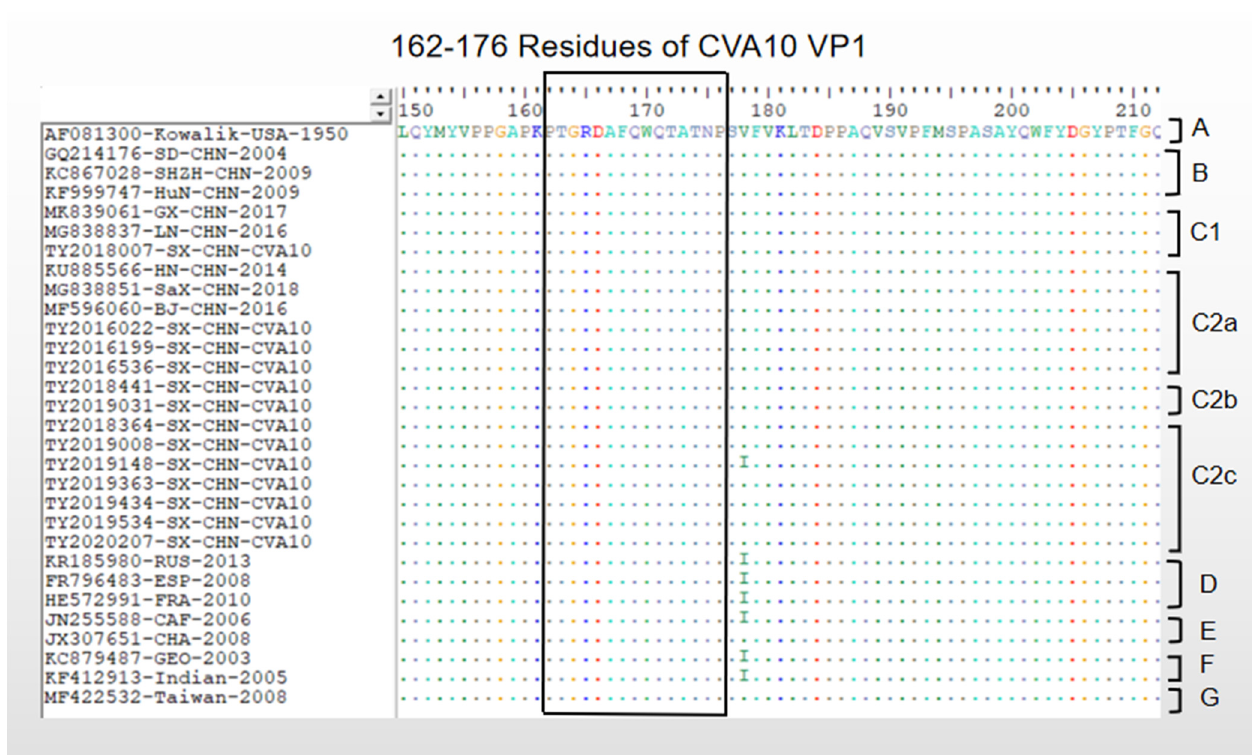
Figure 3. Alignment of 162–176 residues of VP1 amino acid sequences of CV-A10. According to the phylogenetic analysis of CV-A10 (Figure 2), the VP1 amino acid sequences of 30 CV-A10 in genotype A-G were selected. Dots represent the same residues as the prototype strains (AF081300-Kowalik- USA-1950). The regions of 162–176 residues are framed with black lines.